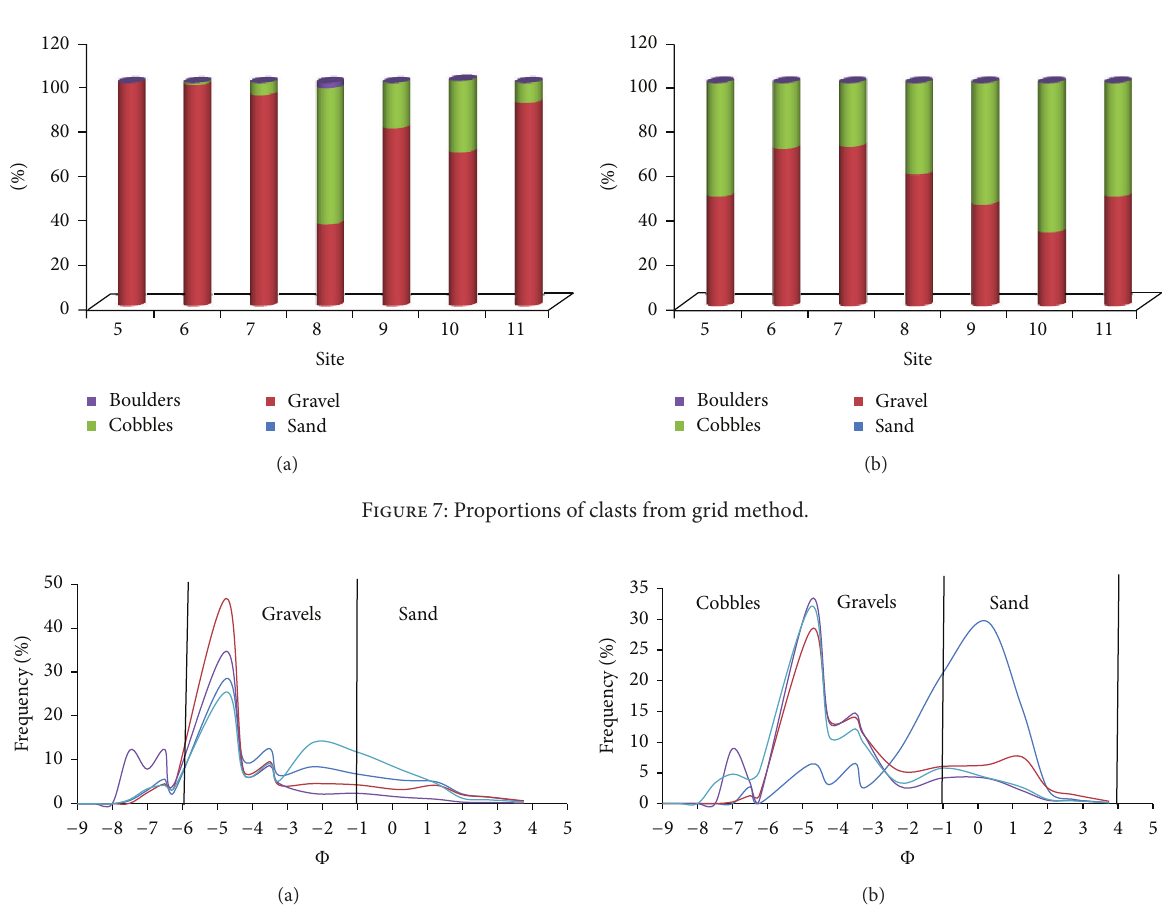
Figure 8: Histograms representing the grain size distributions for volumetric sampling (NB: 𝐷 (mm) = 2 −Φ